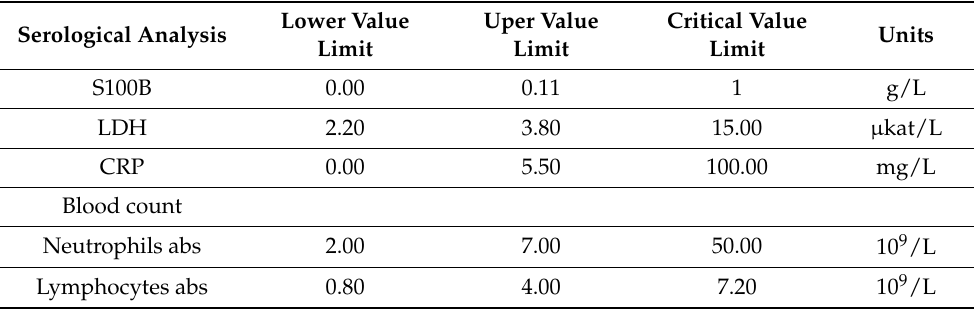
Table 1. Serological and blood count markers used and their laboratory standard deviations, and critical values (Institute of Medical Biochemistry and Laboratory Diagnostics, General University Hospital and First Faculty of Medicine, Charles University, Prague, Czech